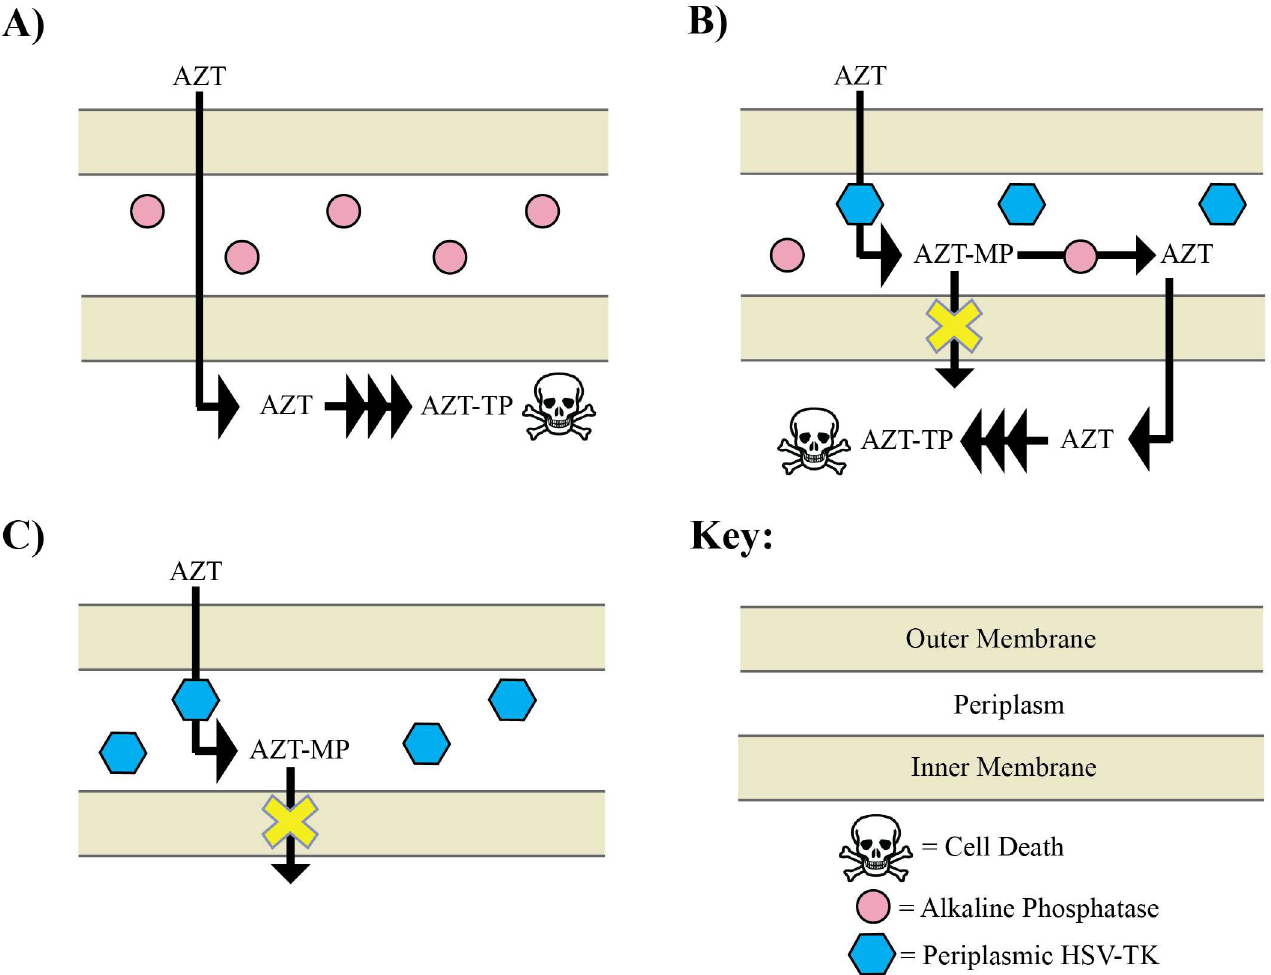
Fig 1. Positive selection for HSV-TK activation of AZT. A) In typical cells, AZT penetrates the outer membrane,periplasmand inner membrane to be metabolized in to its triphosphate form to generate genotoxicity towards E . coli . B) When HSV-TK is exported to the periplasmAZT is phosphorylated in the periplasm; however, PhoA counteracts by dephosphorylatingthe AZT-MP, allowingAZT to penetrate the inner membrane causing genotoxicity. C) In cells lacking PhoA but containingperiplasmic HSV-TK, AZT is phosphorylated and AZT-MP cannot cross the inner membrane. Thus, periplasmicHSV-TK provides AZT resistance to phoA –